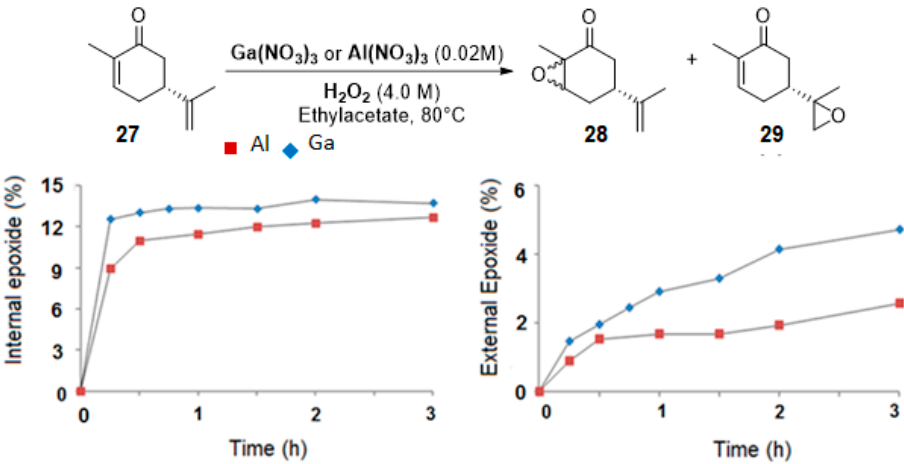
Figure 6. Epoxidation of ( R )-carvone. Gallium vs. Aluminum salts. Conditions: Carvone (1.0 M) with H 2 O 2 (4.0 M) containing 3.2 M H 2 O, Catalyst (0.02 M), Ethylacetate, 80 °C (adapted from reference [24]).